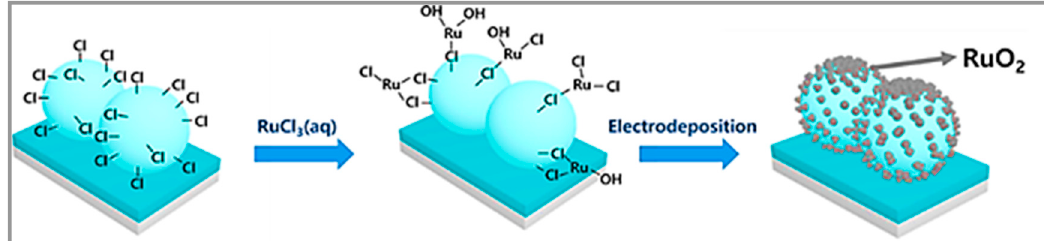
Figure 21. Illustration of the preparation process of the PS/RuO2 core-shells, including the surface modification of PS through the formation of the Ru − Cl bonds on Cl, terminated groups before electrodeposition step. Reprinted with permission from [436], Copyright. 2018, American Chemical Society.